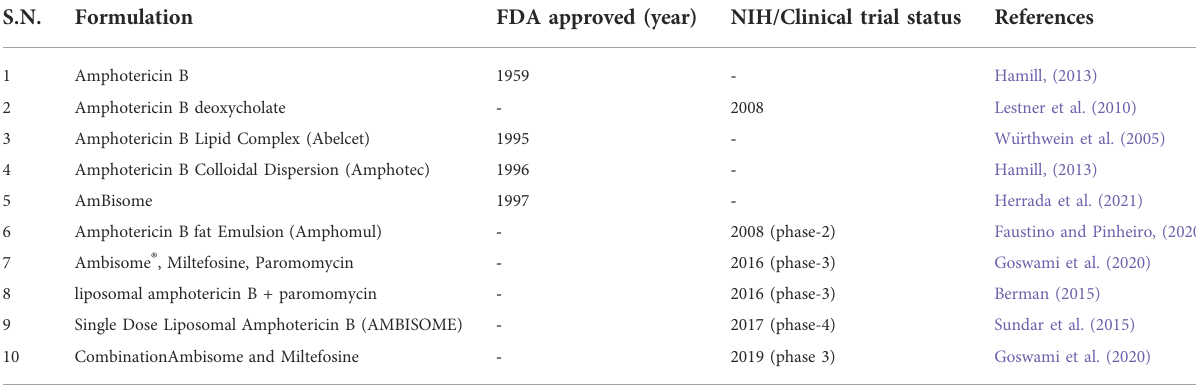
TABLE 1 FDA approved and under clinical trial of different formulation of AmB for VL are listed. S.N.